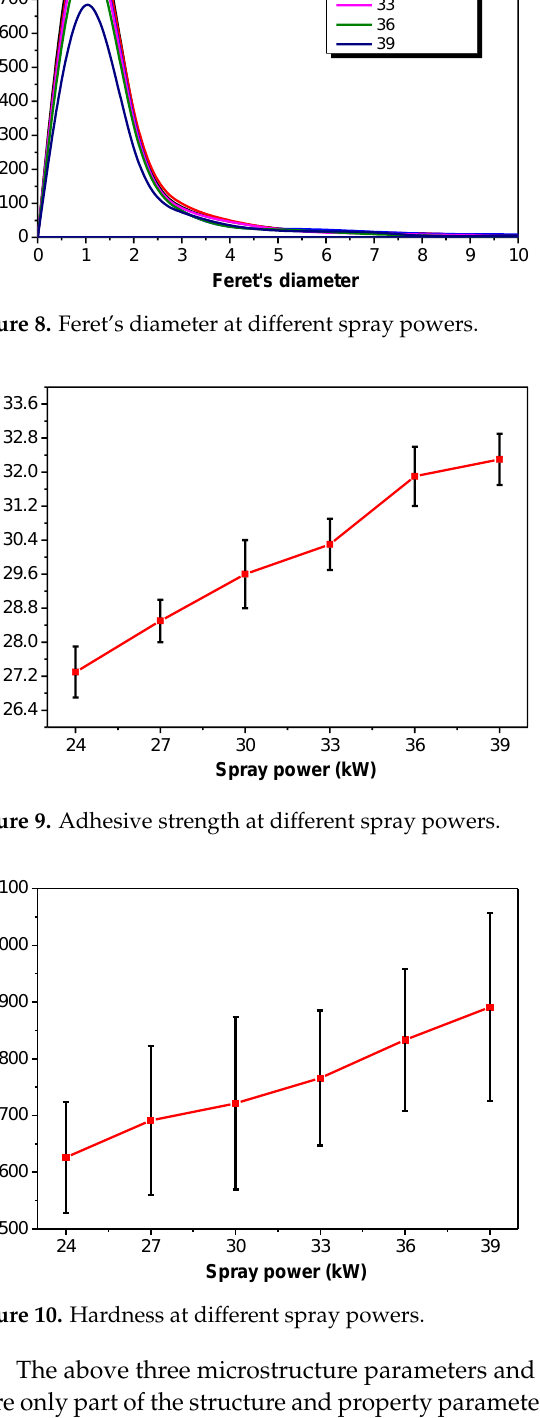
Figure 8. Feret’s diameter at different spray power s.